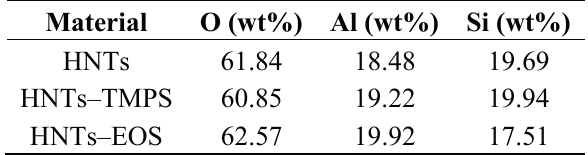
Table 2. Energy-dispersive X-ray spectroscopy (EDS) analysis